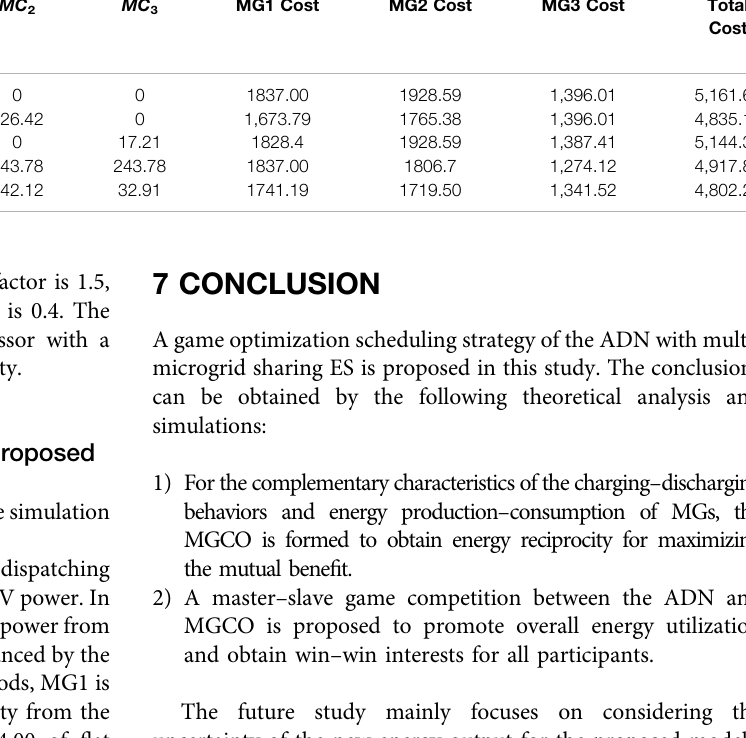
TABLE 4 | Comparison of cost in various forms of cooperation (CNY). Coalition